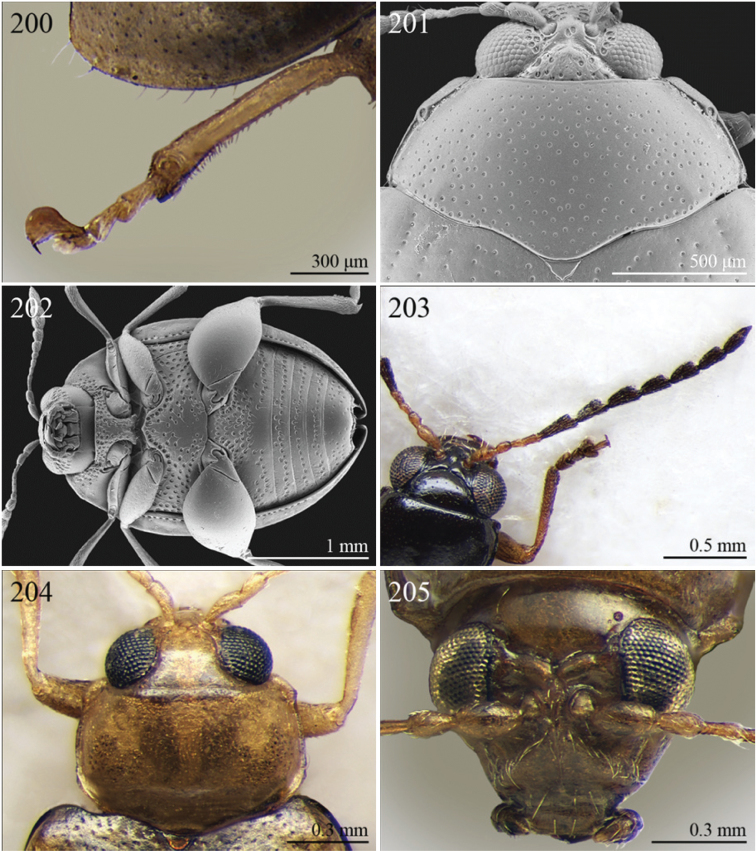
Morphological characters. 200
Hyphasis sita (Maulik), hind tibia and metatarsus 201
Jacobyana bezdeki Biondi & D’Alessandro, head and pronotum in dorsal view 202 Ditto, ventral parts 203
Kanonga atra Bechyné, head and right antenna in dorsal view 204
Kenialtica muhavura Bechyné, head and pronotum in dorsal view 205
Kimongona callifera Bechyné, head in frontal view.